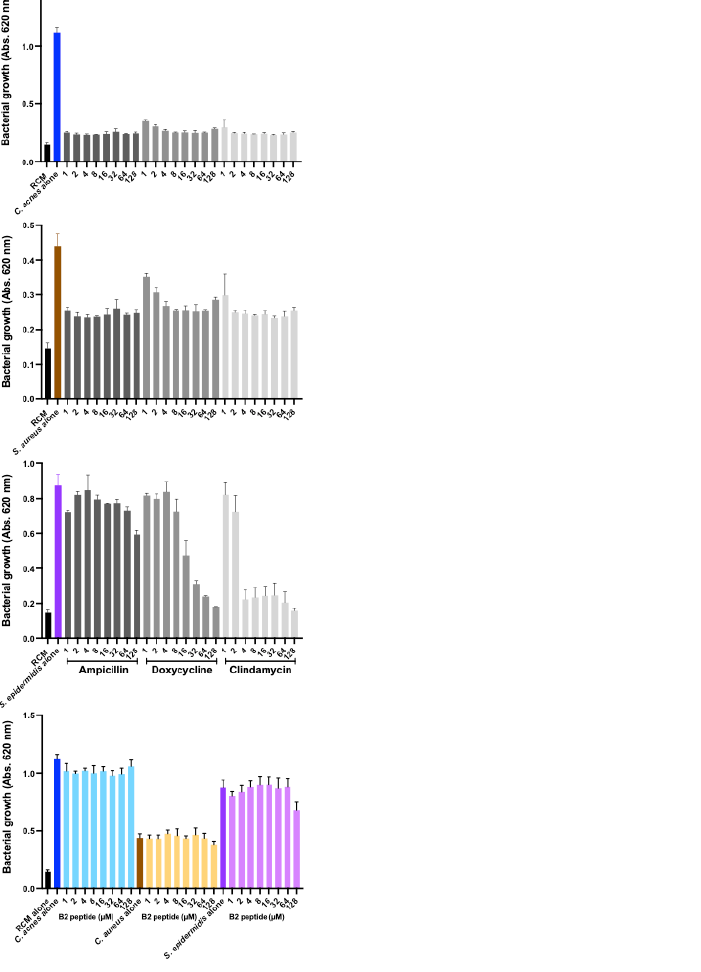
Figure 10. The CAMP1-derived B2 peptide preserves bacterial growth. C. acnes 6919, S. aureus and S. epidermidis were grown in the presence of ( A – C ) antibiotic (ampicillin, doxycycline, clindamycin) and ( D ) the B2 peptide, for 5 days and 24 h, respectively. Bacterial growth was monitored at 620 nm.